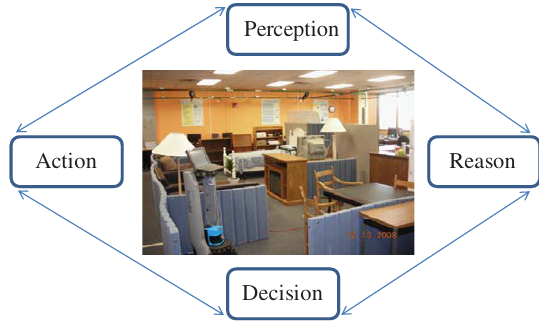
Fig. 2. Cognitive assistive living environment.